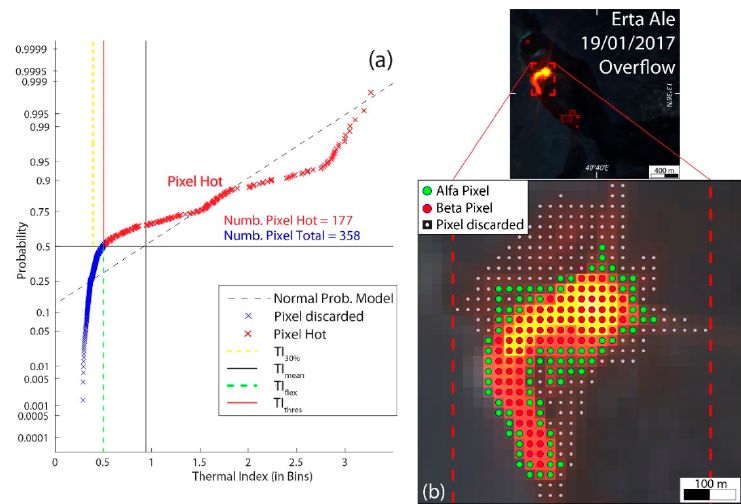
Figure 5. Algorithm application on Erta Ale [60] lava flow case, 19/01/2017. ( a ) Normal Probability Distribution plot of the Thermal Index (TI) of the analyzed cluster. In red and blue, hot selected and discarded pixels. Dotted black, solid black, dotted yellow, dotted green and red lines represent, respectively, the theoretical normal distribution model, TI mean , TI flex , TI 30% and TI thres hot threshold, fitting with the TI flex in this case. ( b ) SENTINEL-2 RGB (12-11-8a) image zoomed over cluster analyzed; in green, red and withe, alfa-triggered, beta-triggered and discarded pixels; respectively.